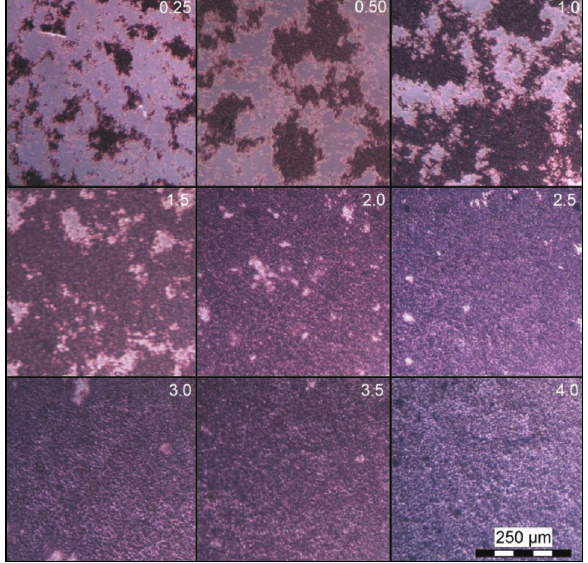
Figure 5. Optical microscope images of Au (dark) thin films on glass (light) with different Au loads (given in g m –2 ).